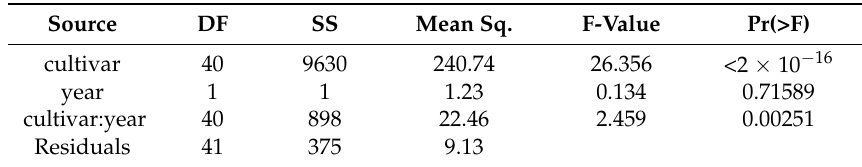
Table 3. Results from an analysis of variance (ANOVA) showing an interaction output for t -piceid content by year from the different muscadine grape cultivars (2013–2015). Source DF SS Mean Sq. F-Value Pr(>F)